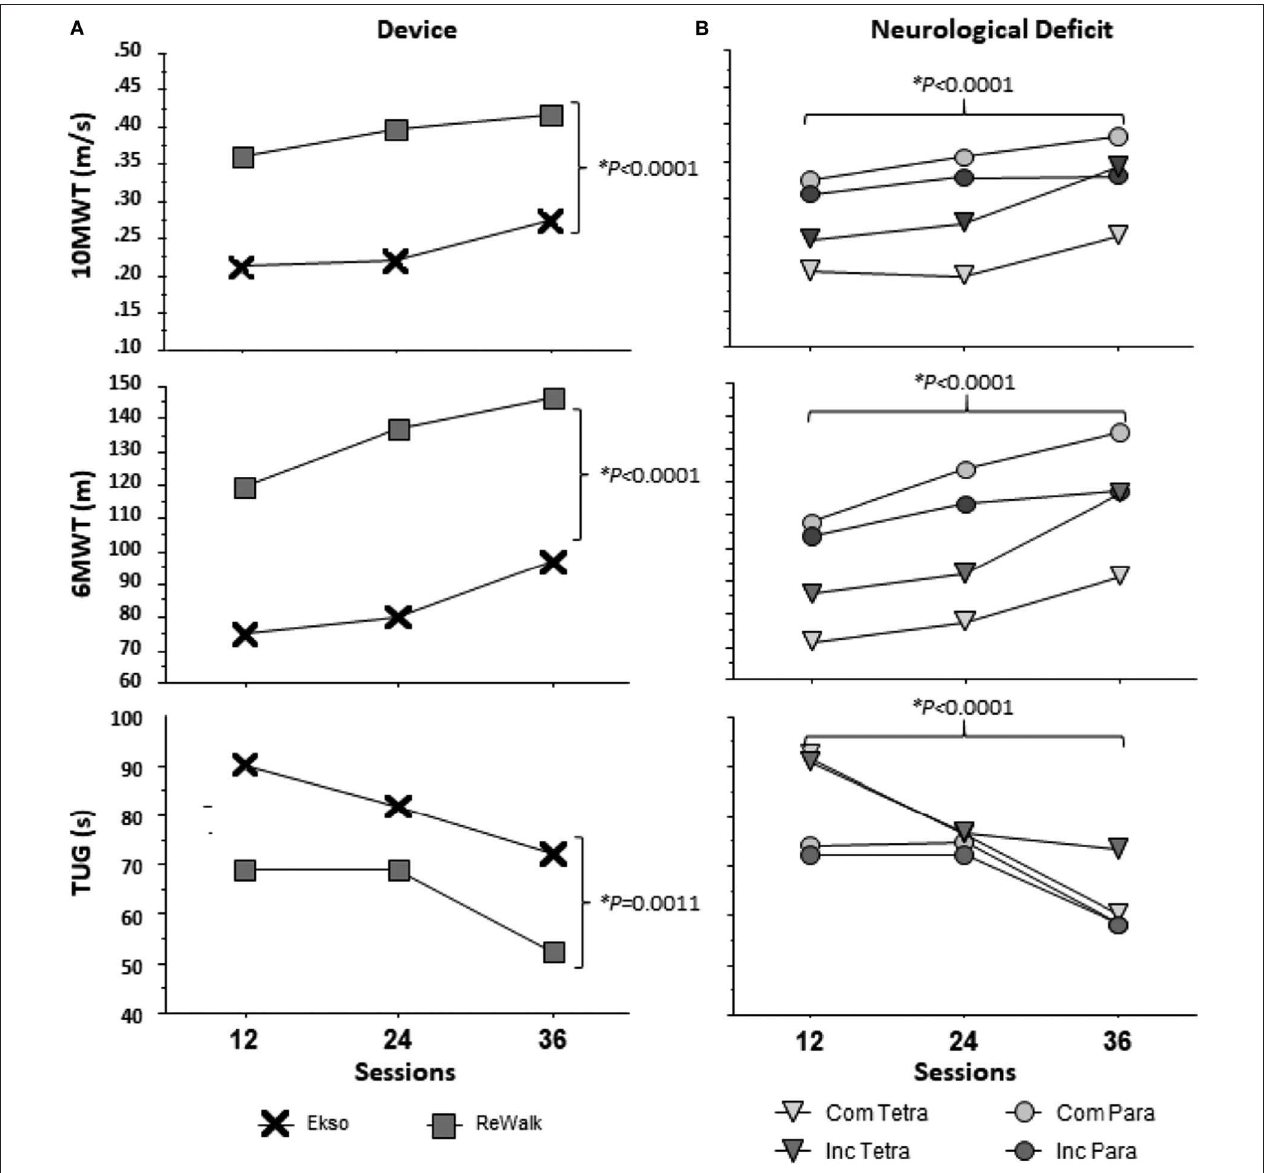
FIGURE 3 | Results of Walking Tests across 12, 24, and 36 sessions by (A) device and (B) neurological deficit. Neurological deficit: Com Tetra (Motor Complete Tetraplegia); Inc Tetra (Motor Incomplete Tetraplegia); Com Para (Motor Complete Paraplegia); and Inc Para (Motor Incomplete Paraplegia). The main effects for neurological deficit (ANOVA: 10MWT ( F (3, 46) = 2.568, p = 0.658), 6MWT ( F (3, 46) = 2.267, p = 0.0933), TUG ( F (3, 46) = 0.946, p = 0.4263)) were not significantly different, but the main effects for sessions and device (10MWT: p < 0.0001, 6MWT: p < 0.0001, TUG-12: p = 0.0006, TUG-24: p = 0.1299, TUG-36: p < 0.0001) were statistically significant for each walk test as